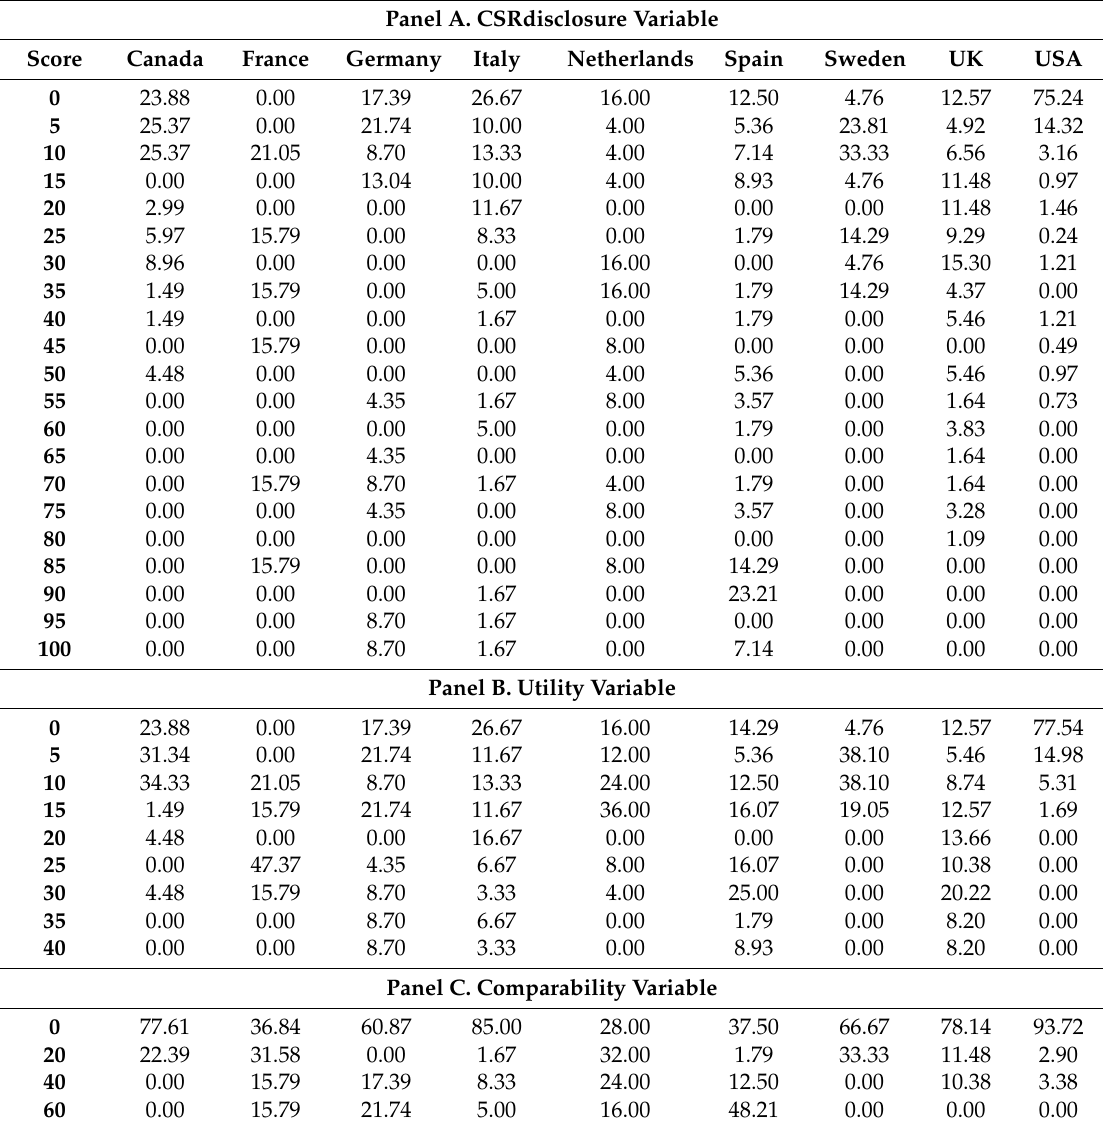
Table 5. CSR disclosures distribution by country in percentage. Panel A. CSRdisclosure